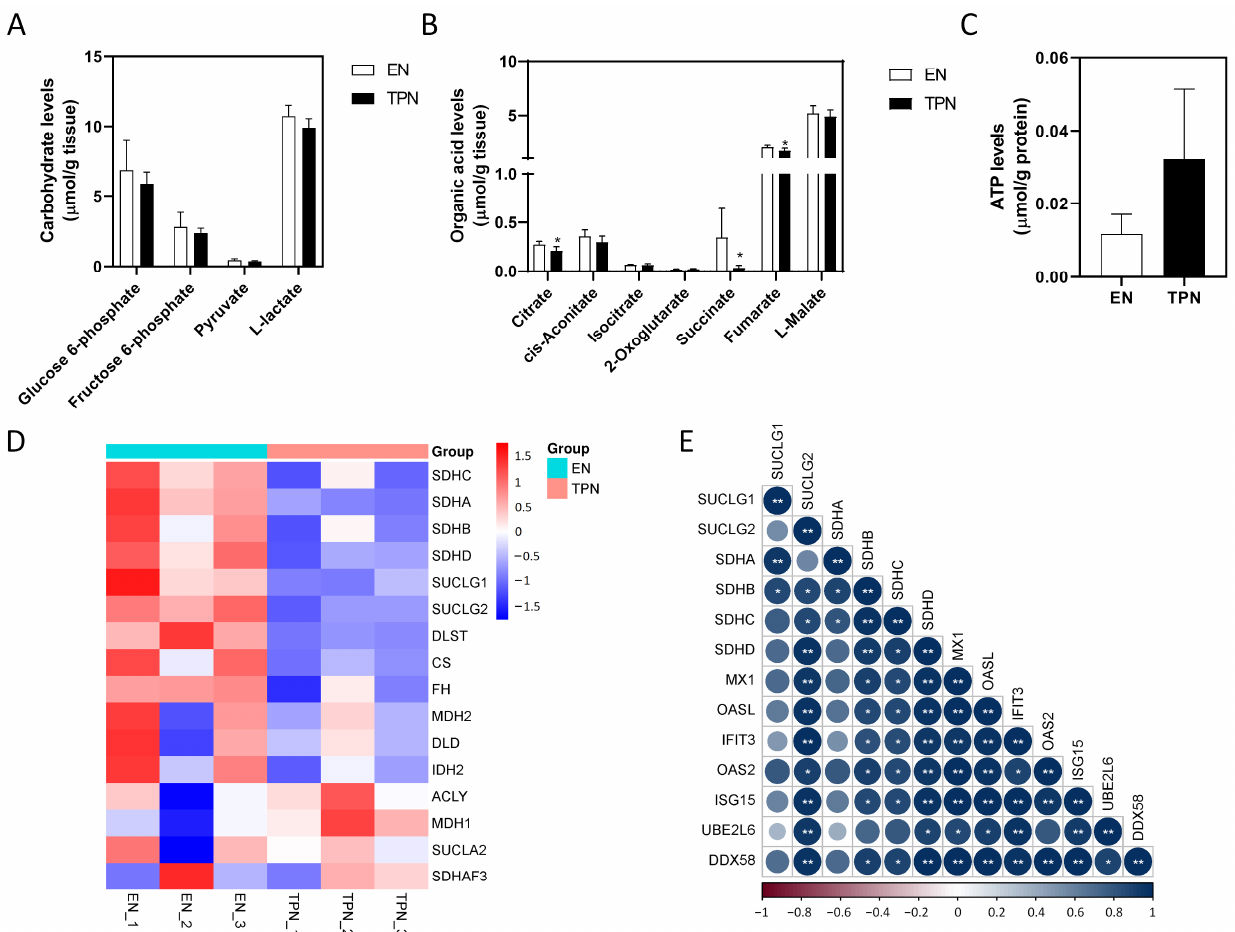
Figure 6. Changes in the metabolomic and proteomic profile of the citrate cycle. ( A ) Tissue levels of carbohydrates involved in glycolysis. ( B ) Tissue levels of organic acids involved in TCA cycle. ( C ) Tissue levels of Adenosine 5 ′ -triphosphate (ATP). Data are presented as mean ± SD. * p < 0.05 ( n = 5–6/group). ( D ) Heatmap of proteins involved in TCA cycle. ( E ) Correlation matrix of proteins involved in succinate metabolism and anti-viral immune responses. Color indicates the value of correlation coefficient (* p < 0.05, ** p < 0.01).